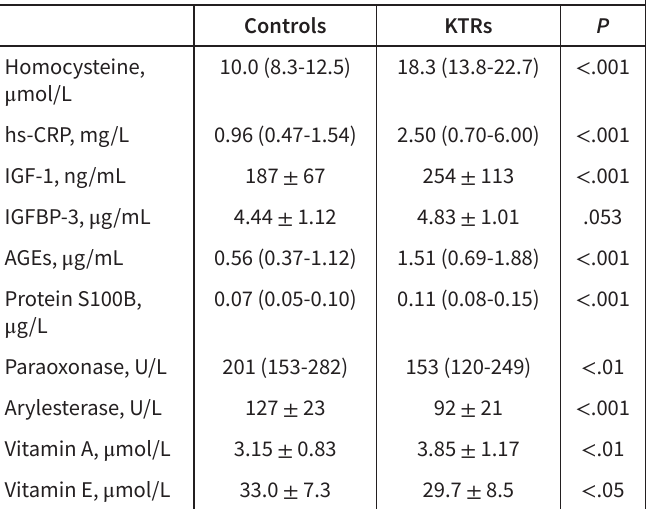
Table 2. Oxidative Stress and Inflammatory Markers of Control Subjects and Kidney Transplant Recipients